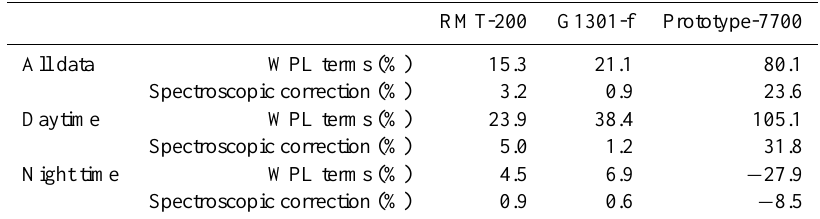
Table 4. WPL terms and spectroscopic correction given as percentages of the uncorrected raw covariance. Positive and negative values mean that the correction increases the upward and downward directed flux, respectively. Daytime was defined as those periods when the Sun’s elevation angle was above 0 ◦ and nighttime as those periods when it was below − 3 ◦ . Only data from a period when all the instruments were working (17 April–17 May) was used in calculating the values in the